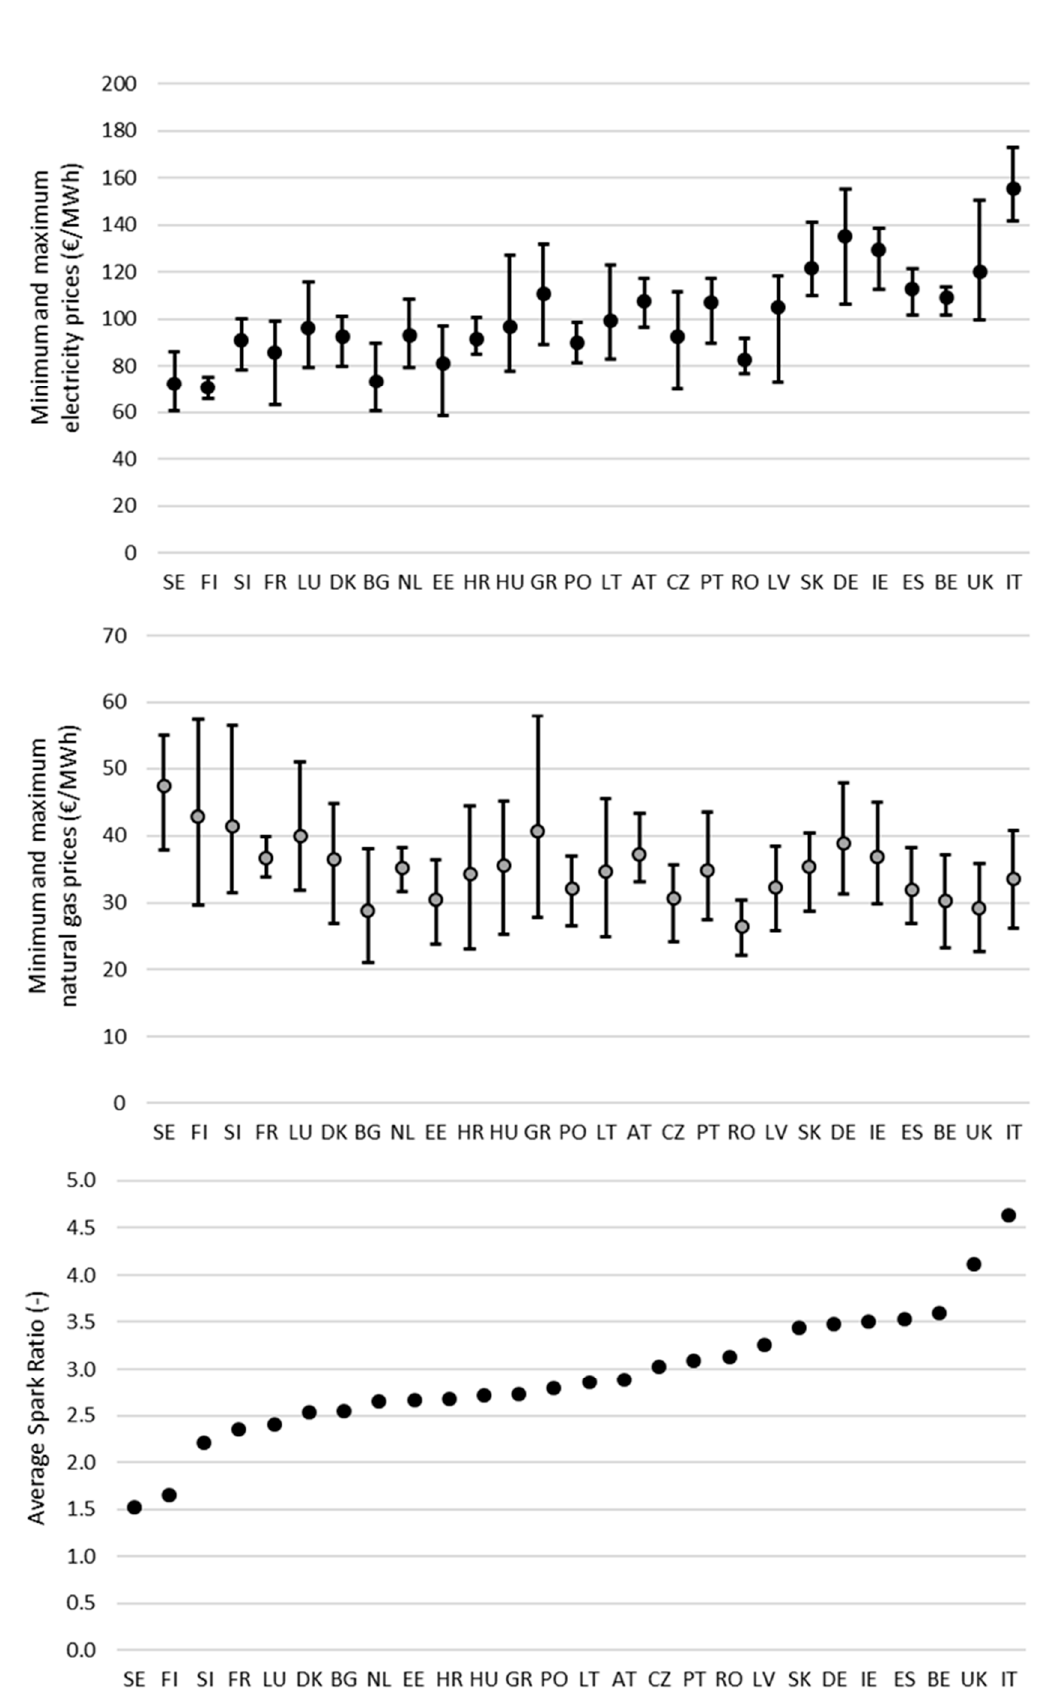
Figure 2. Average, minimum, and maximum energy prices and spark ratios of European countries (values for the 2008–2018 time period).